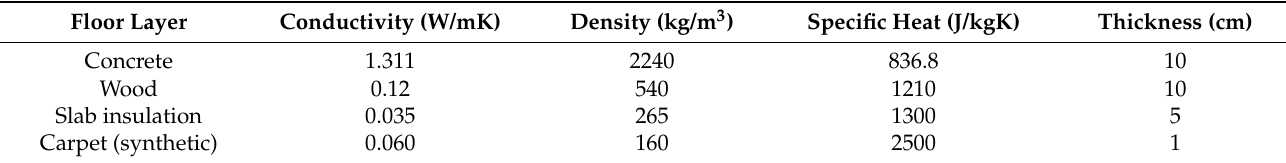
Table 5. Thermal and physical properties of materials in floor layers.